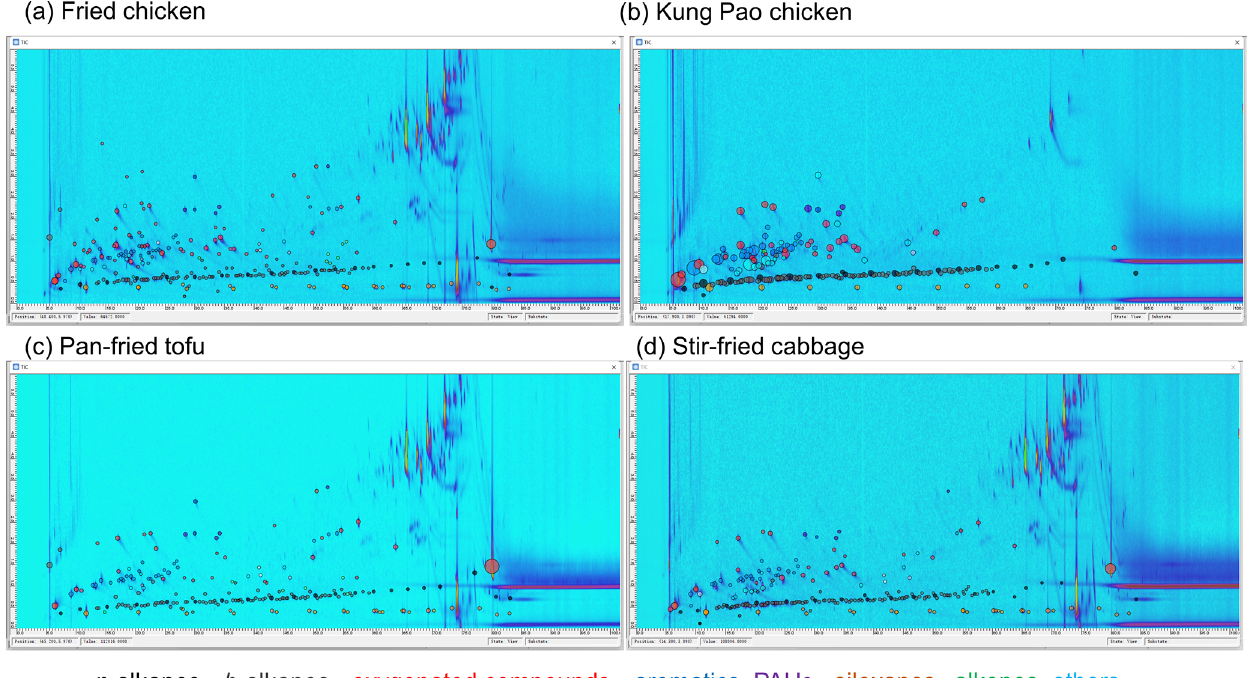
Figure 1. Chemical identified from fried chicken (a) , Kung Pao chicken (b) , pan-fried tofu (c) , and stir-fried cabbage (d) emissions. Column and Tenax TA bleeding after 75 min in first retention time are excluded from qualification, quantification, and 2D binning processes. Blobs are coloured by chemical groups.